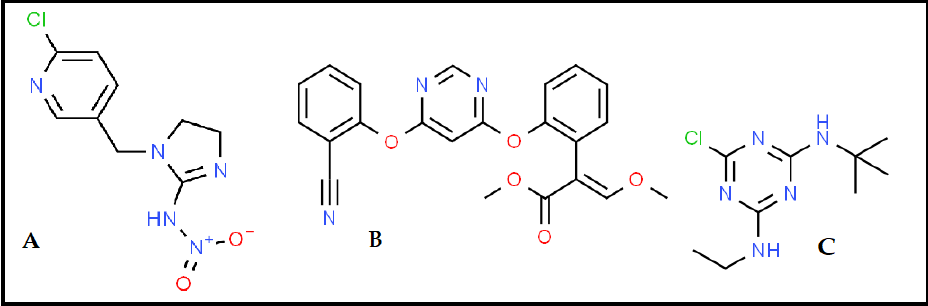
Figure 1. The chemical structure of the compounds under study: ( A ) imidacloprid, ( B ) azoxystrobin, and ( C ) Terbuthylazine.